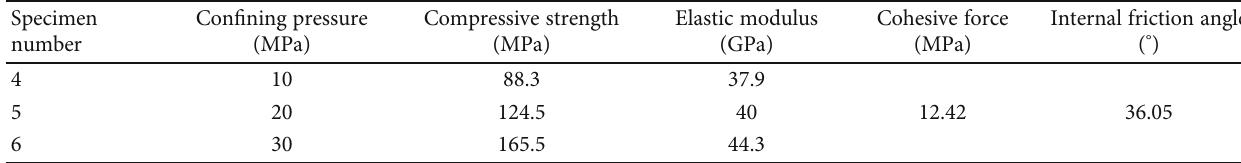
Table 4: Results of the triaxial compression test.